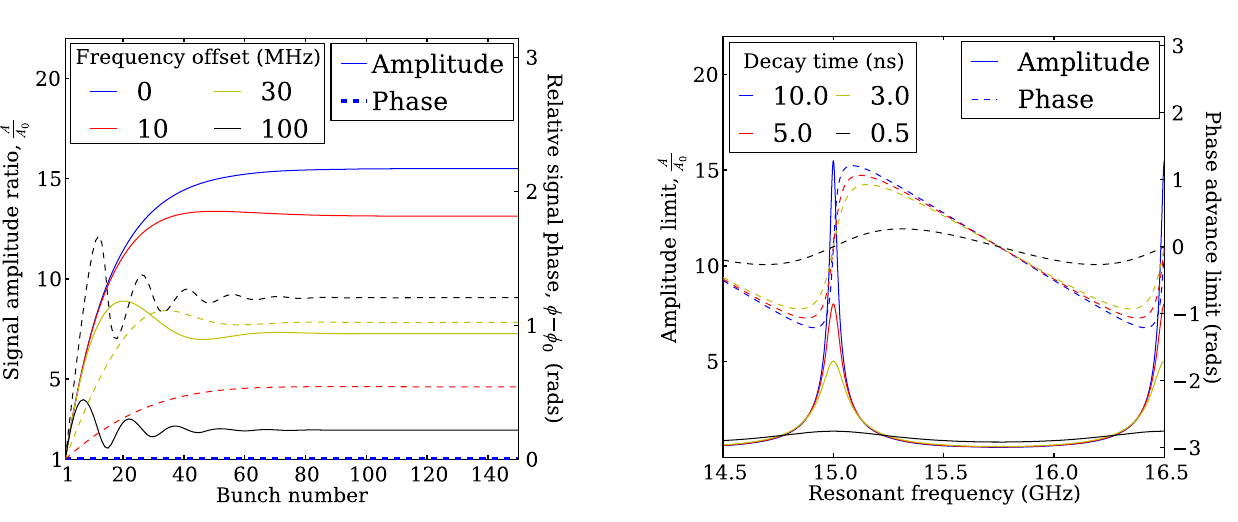
FIG. 2. Convergence limits in amplitude and phase of the multiple bunch signal as the number of bunches tends to